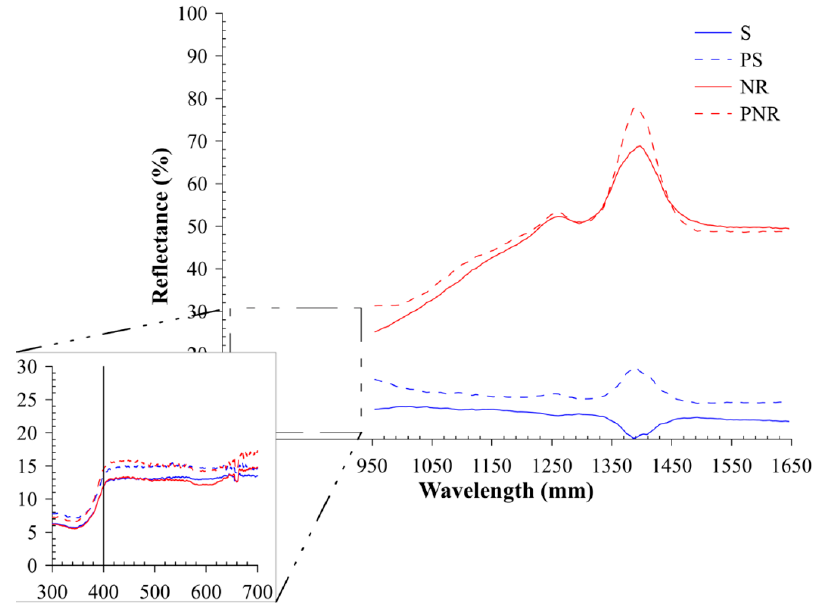
Figure 6. Spectral Figure 6. Spectral reflectance. Observing the UV-Vis region (small square) is possible to detect a similar behaviour between the specimens, which can indicate that the incorporation of the NRP (blue line) does not affect these reflectance values, lower than 20%, and also the colour (see Table 2). The specimens with NRP (blue line) had higher NIR reflectance than the standard speci- mens (red line). The primer (dash line) also positively influenced the NIR reflectance. The diffuse solar reflectance in the solar spectrum regions (UV/Vis/NIR) was calcu- lated according to Equation (1) and Equation (2), and the results are presented in Figure 7. Figure 7. UV-Vis-NIR reflectance. Since the finishing coating and primer layer incorporate TiO 2 particles, which con- tribute to a lower degradation of polymeric-based materials due to UV radiation [65,66], low values of UV reflectance were observed. These results and the colour parameters (in Table 2) confirmed this effect. The Vis reflectance is related to the visible colour of the finishing coating. Conse- quently, light colours will have a higher reflectance in this region at the same time that the NIR reflectance will significantly affect the absorbed solar energy. Several studies stated